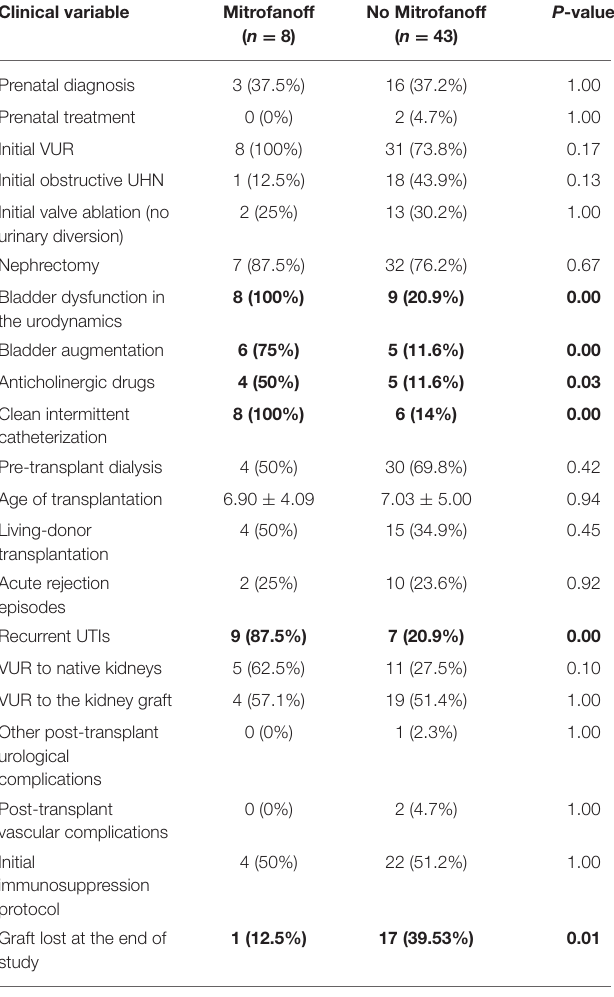
TABLE 2 | Comparative analysis of clinical characteristics in patients who did and did not undergo the Mitrofanoff procedure. Clinical